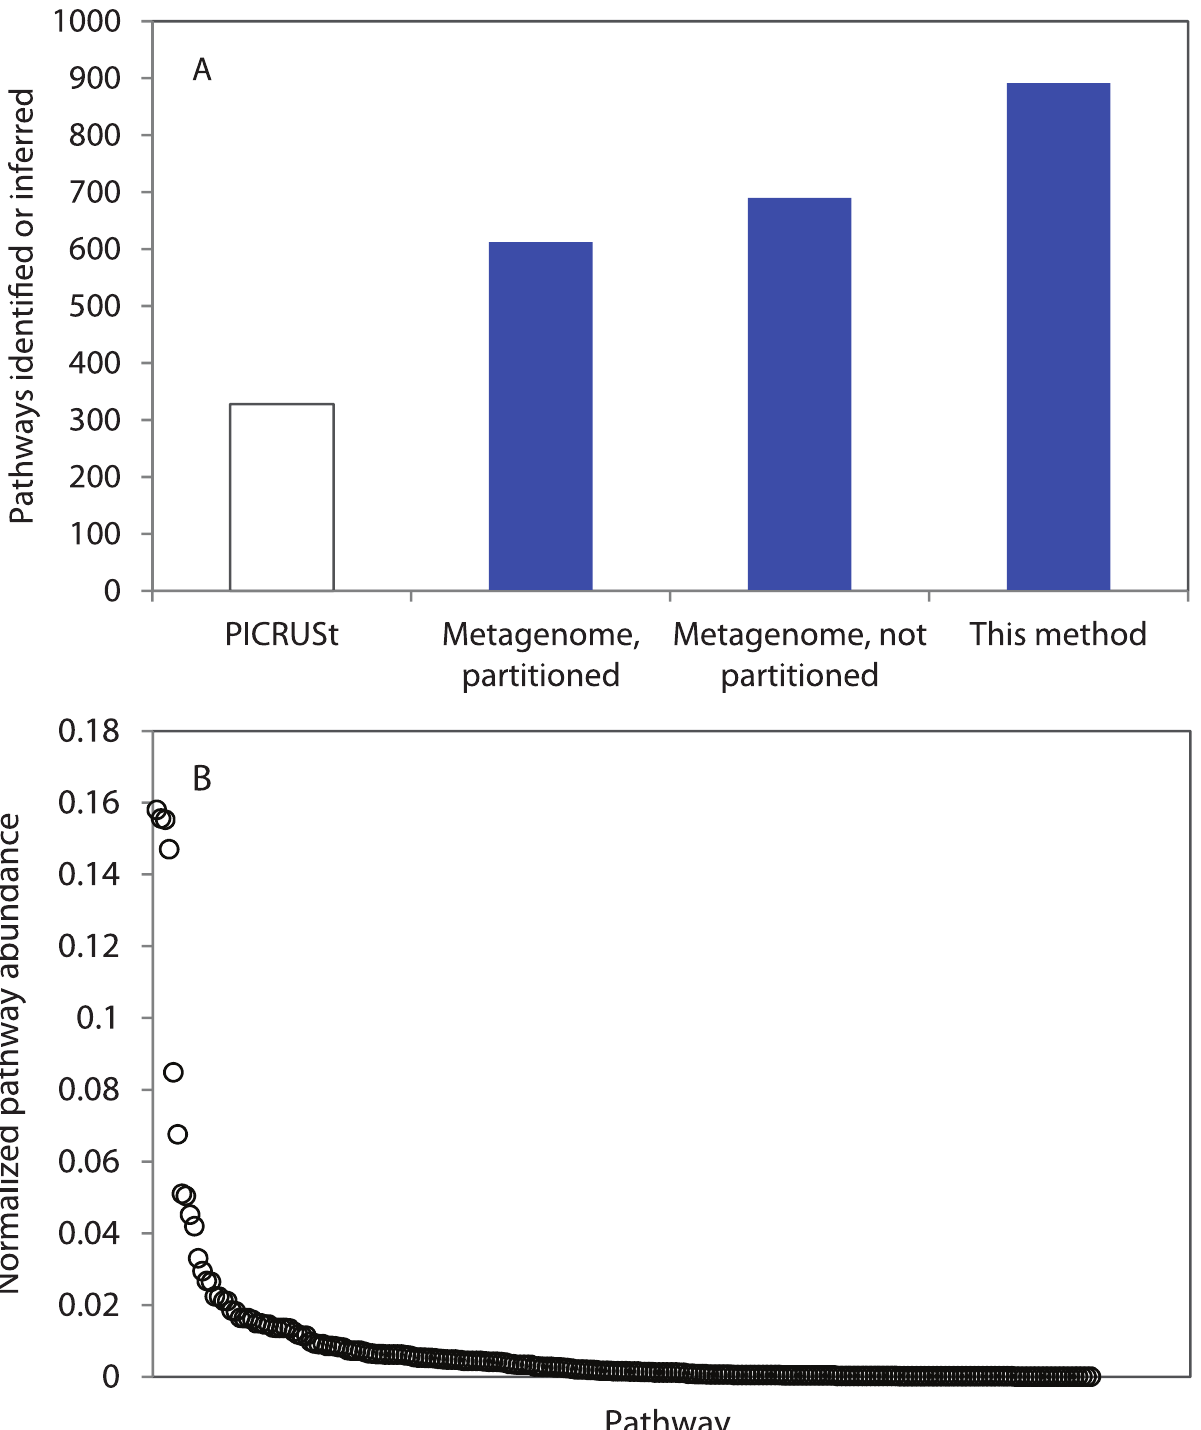
Fig 2. Comparison of metabolic inference and metagenomic analysis. A) Metabolic pathways identified (metagenomes) or inferred (PICRUSt, this method) with each method. PICRUSt pathways (indicated by white bar) are based on the KEGG ontology, thus the number of pathways inferred is not directly comparable to the other methods which are based on the MetaCyc ontology. B) The abundance of pathways inferred for but not identified in the metagenome.